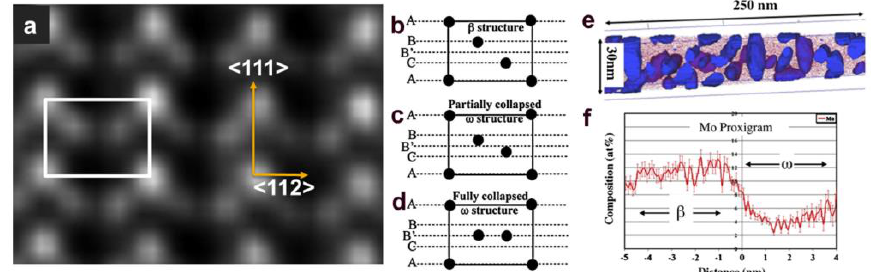
Figure 14. ( a ) The HAADF STEM image of fully transformed ω -phase in a model binary Ti-9 at. % Mo alloy [138]. ( b – d ) show the sequence of collapse of {111} planes of the bcc beta matrix to form ω -phase embryos. ( e ) shows the atom probe tomography (APT) reconstruction and ( f ) is the corresponding proximity histogram Mo concentration profile across the β -phase and ω -phase showing the Mo depleted ω -phase regions in the bcc beta phase matrix. (Reprinted with permission from Acta Materialia, vol. 60, A. Devaraj et al., Experimental evidence of concurrent compositional and structural instabilities leading to ω precipitation in titanium-molybdenum alloys, 596–609, 2012).